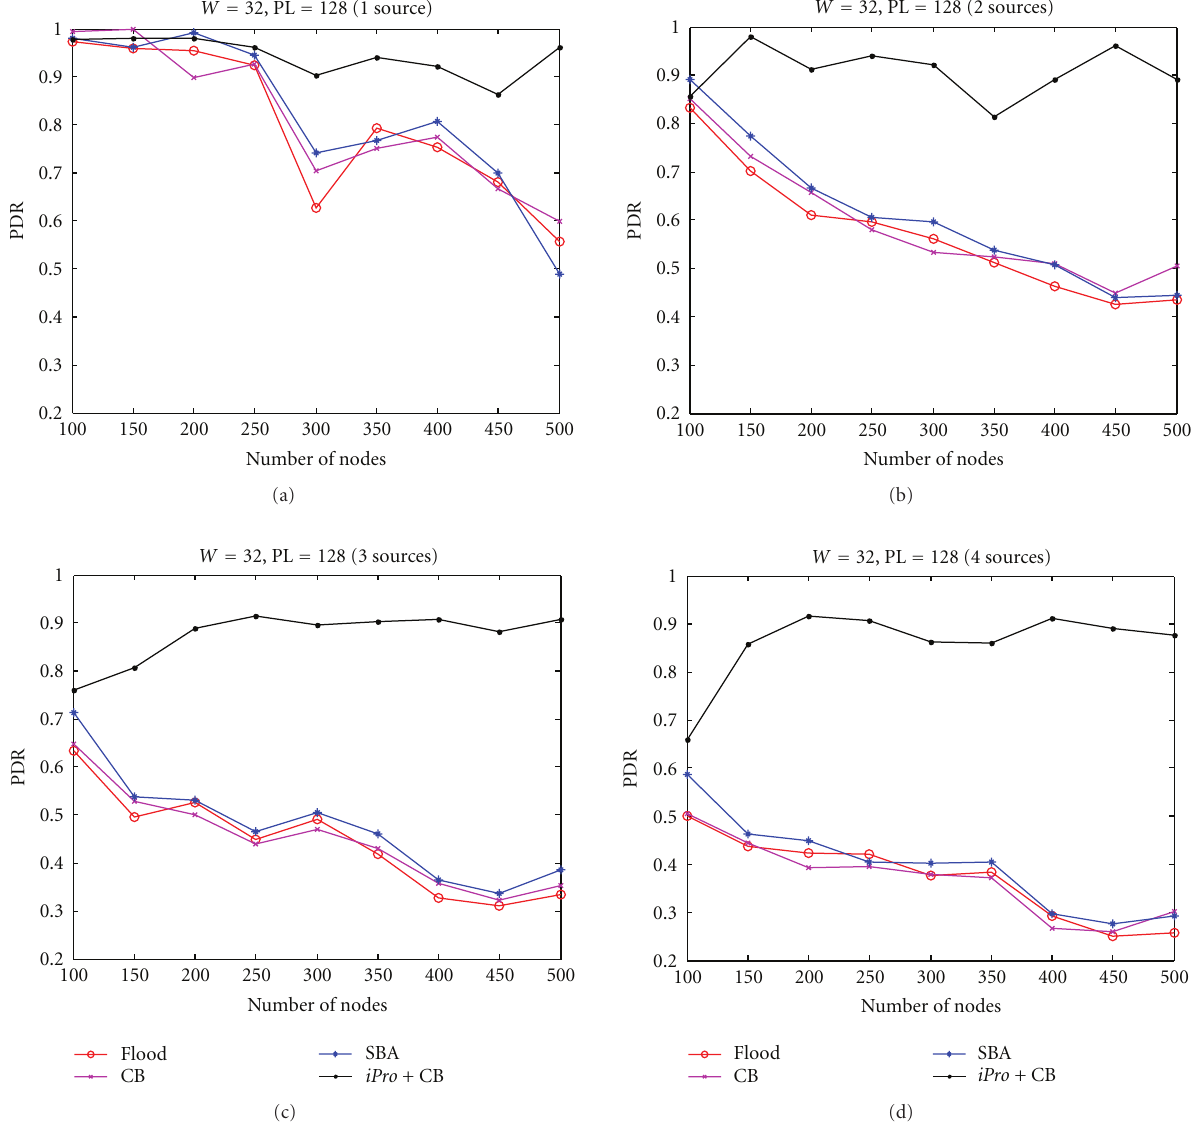
Figure 6: PDRs of multisource multihop broadcasting scenario when W =